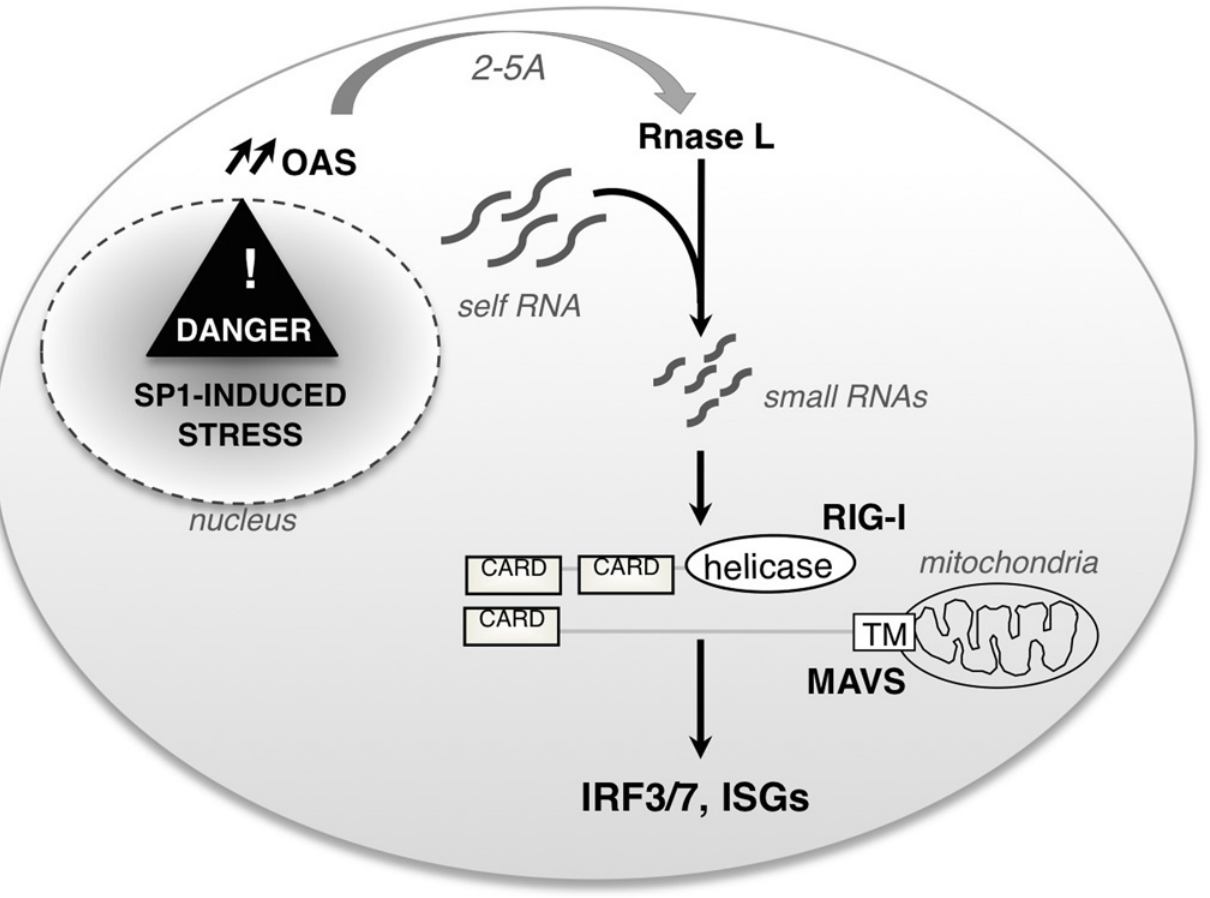
Fig 6. A schematic overview of the signaling pathway triggered by increased Sp1 level. Upon Sp1 overexpression, Oas2 and Rnasel genes are upregulated and small self-RNAs are produced. Sensing of small self-RNAs leads to the activation of the sensor RIG-I, the IRF3/7 transcription factors and downstream effector targets such as